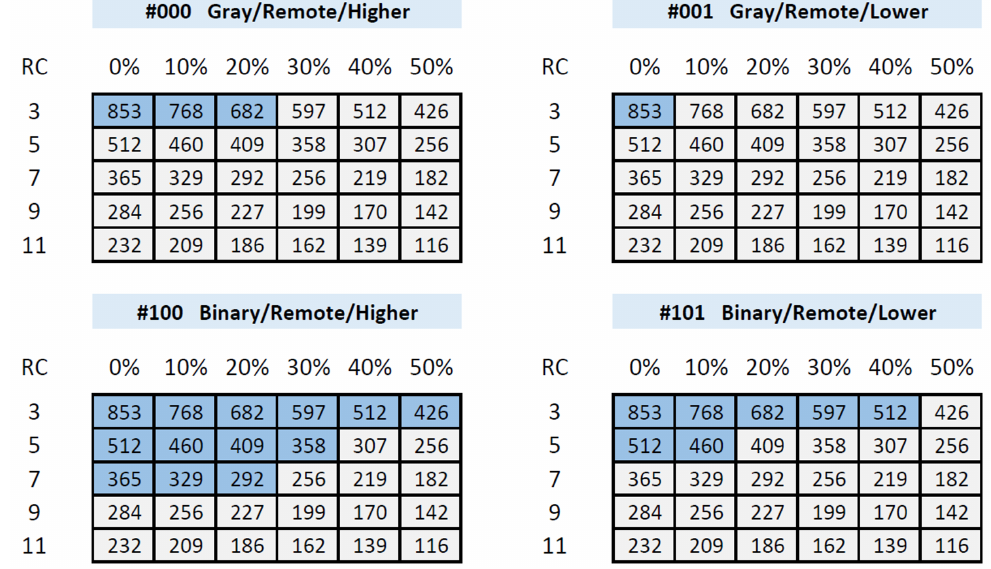
Figure 14. Pass/Fail in key retrieval for different configurations as a function of the percentage of discarded challenges and the ECC repetition factor (RC).